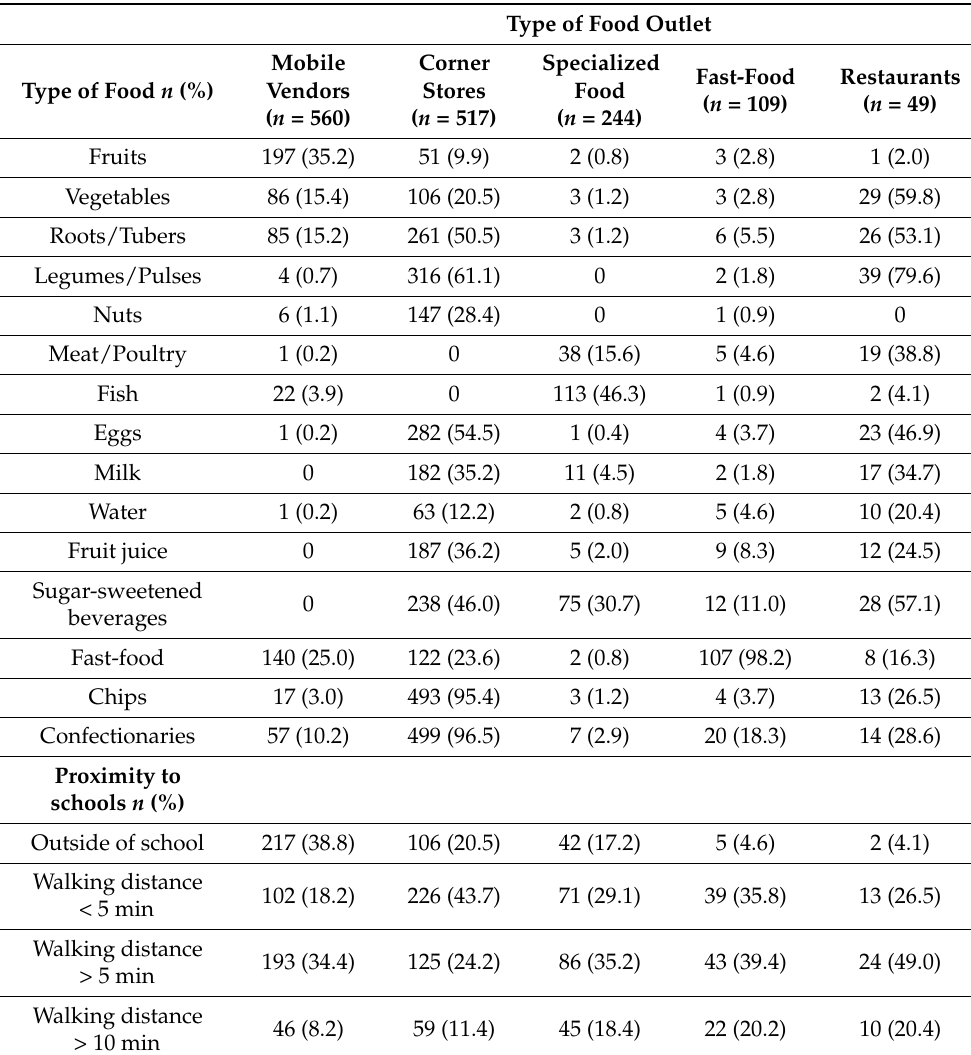
Table 4. Food Availability by Food Outlet